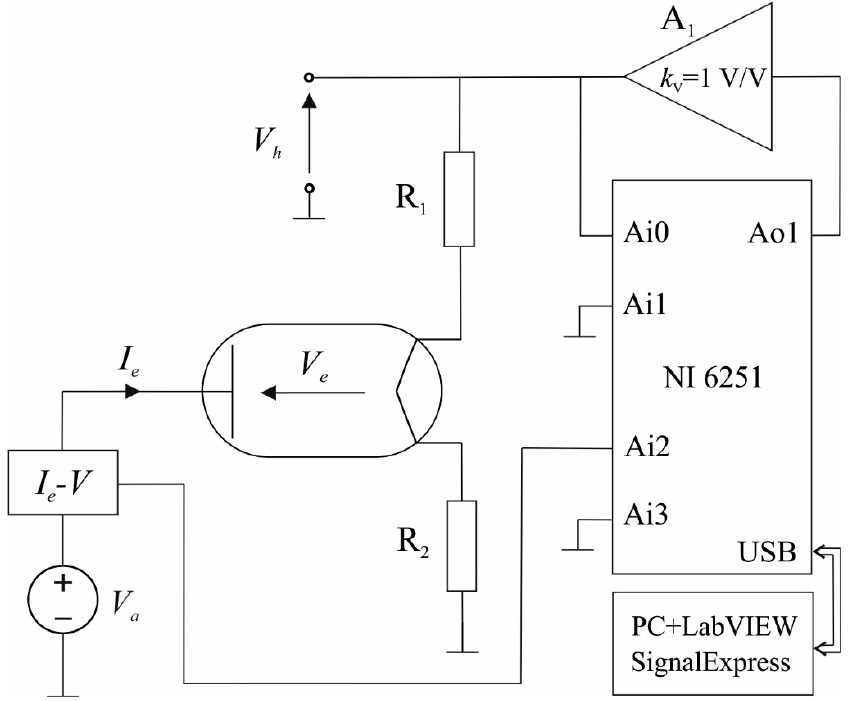
Figure 4. Scheme of the measuring system for determining the dynamic parameters of the electron source. The NI 6251 is a data acquisition card (DAQ) from National Instruments, Ai0–Ai3 are the analog inputs, and Ao1 is the analog output of DAQ, A1 is a power amplifier in a voltage follower configuration with an output current up to 3 A.